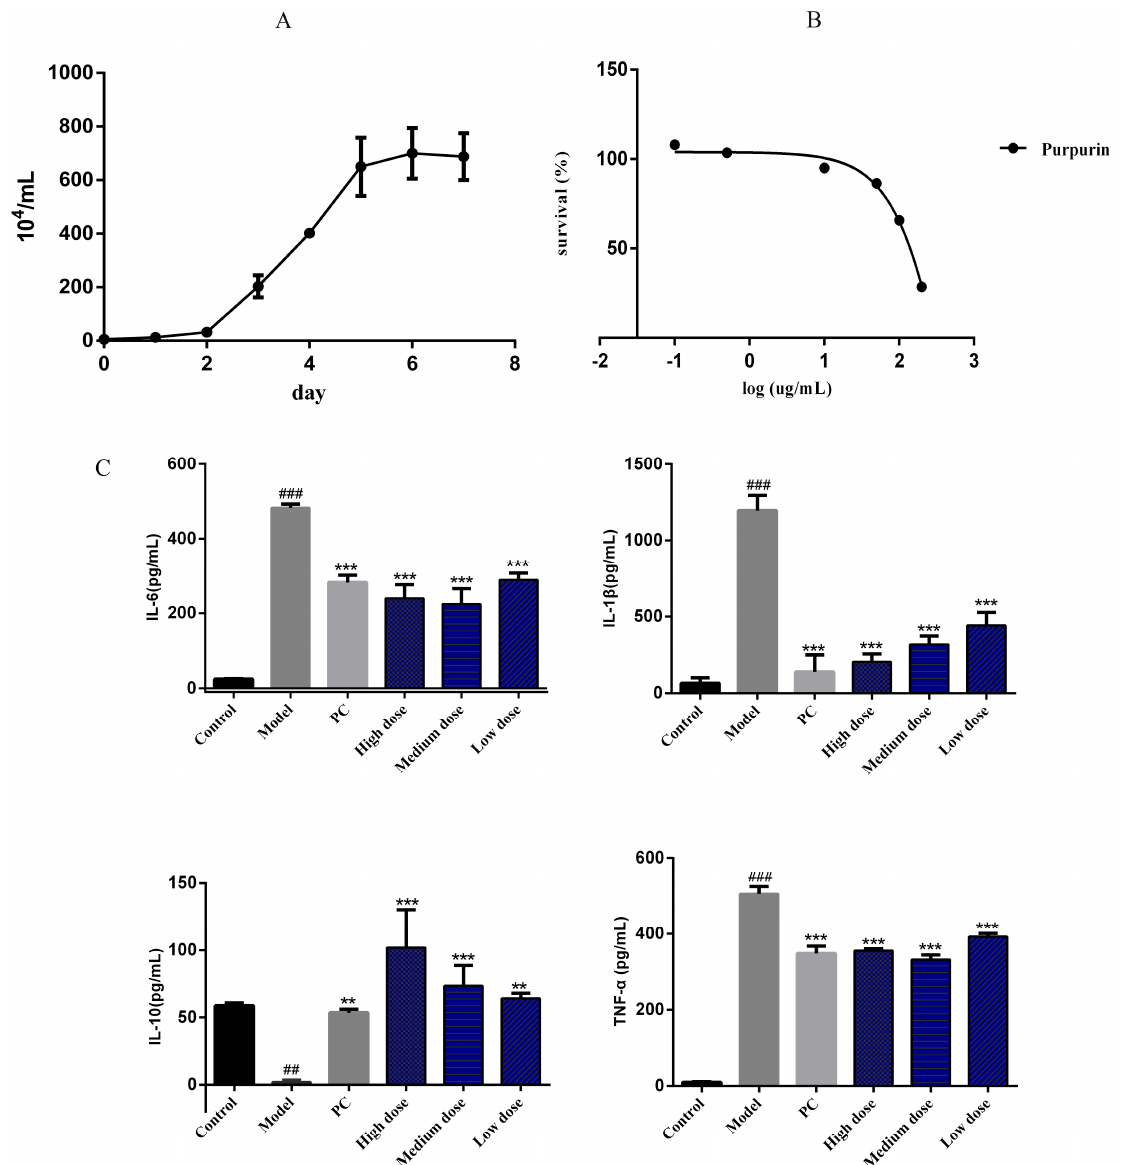
Figure 2. The effect of purpurin on inflammatory factors. ( A ) The growth curve of RAW 264.7 cells, n = 3. ( B ) Assessment of purpurin cytotoxicity using MTT assay. The tested concentrations of pur- purin were 200, 100, 50, 10, 0.5, and 0.1 μ g/mL, respectively, n = 3. ( C ) The anti-inflammatory effect of purpurin, the purpurin concentrations in the high-, medium-, and low-dose groups were 1, 0.5, and 0.1 μ g/mL, respectively. Model: LPS group, PC: positive control group. Data are represented as mean ± SD. ### p < 0.001, ## p < 0.01 vs. control. *** p < 0.001, ** p < 0.01 vs.